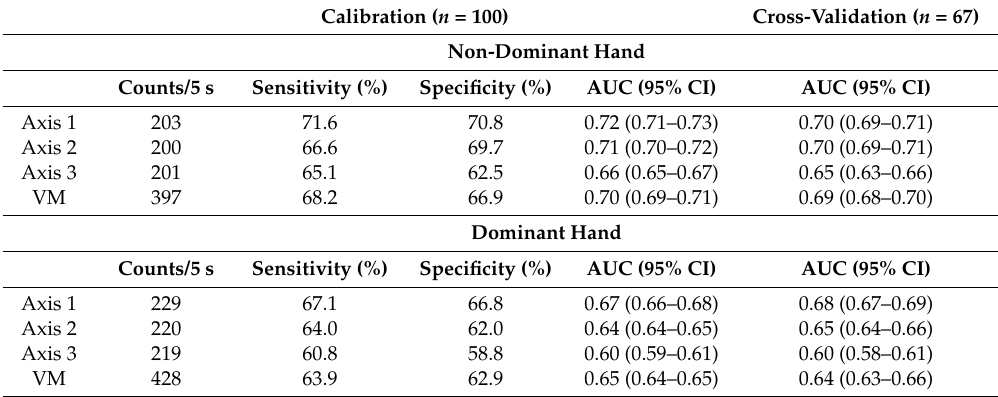
Table 3. Optimal cut-point thresholds, sensitivity, specificity, and AUC based on ROC